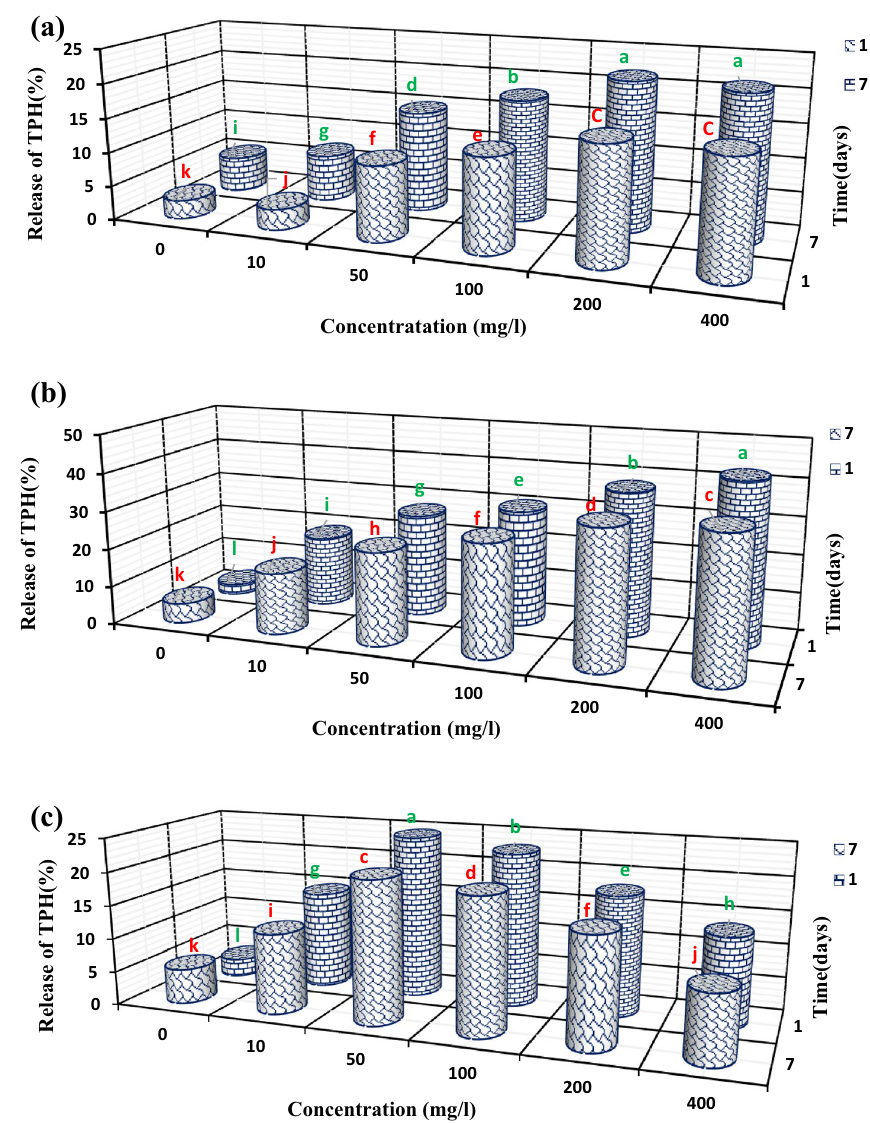
Figure 4. The effects of different concentrations of biosurfactants and bioemulsifier on the release of TPH from the soil at two different times (1- and 7-days). ( a ) Surfactant produced by SH21 isolate, ( b ) surfactant produced by SHA302 isolate, and ( c ) emulsifier produced by SH72 isolate.